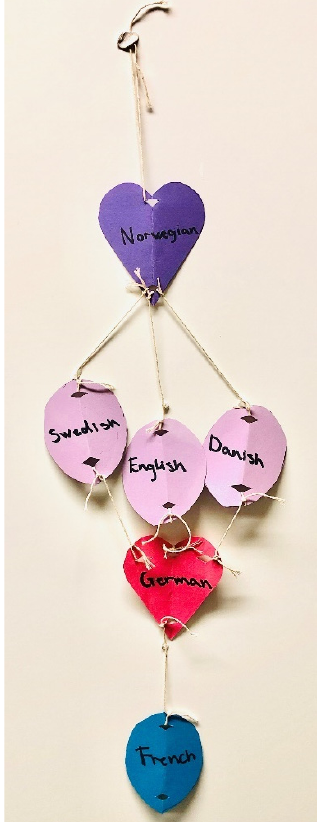
Figure 7. ST5’s DLC